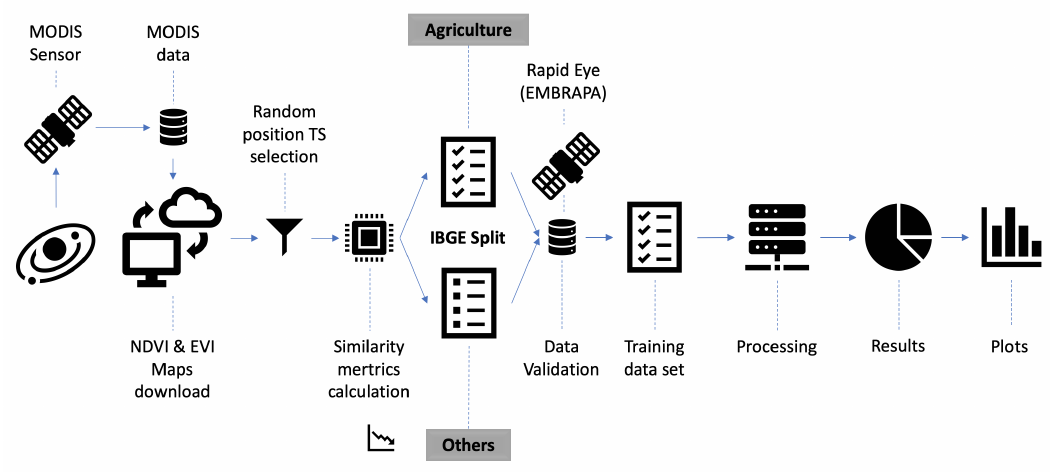
Figure 3. Process Flow—Target groups selected—Agriculture & Other. Elaborated by the